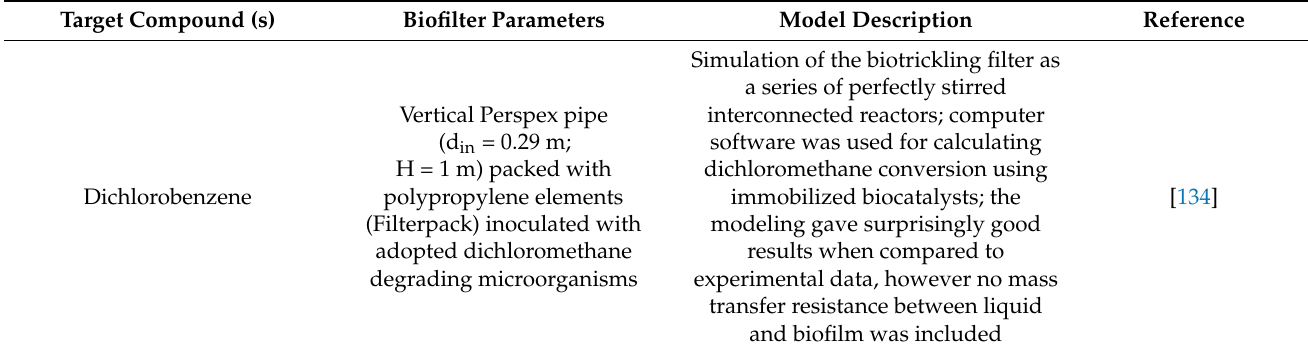
Table 5. Overview of selected mathematical models for biotrickling